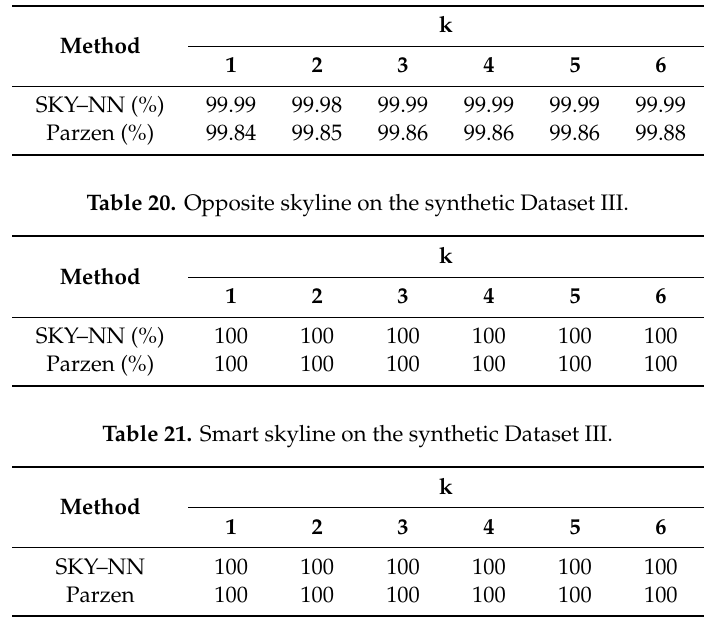
Table 19. Double skyline on the synthetic Dataset III.